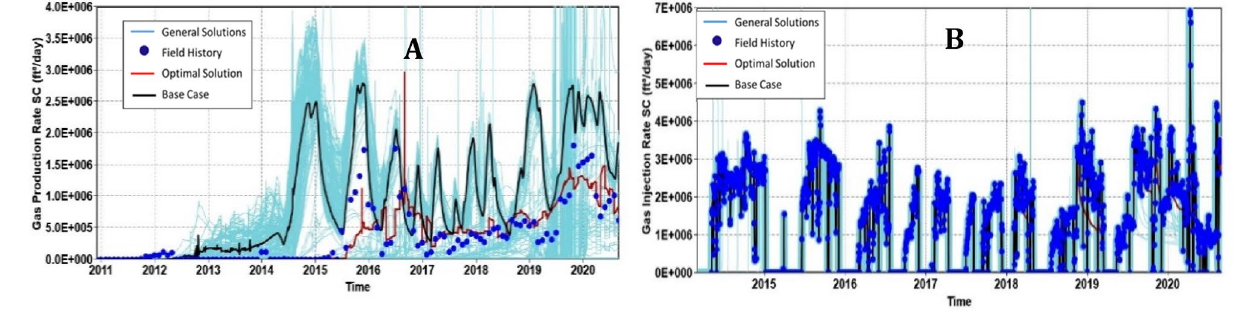
Figure 5. History matching performances on the ( A ) gas production, ( B ) gas injection